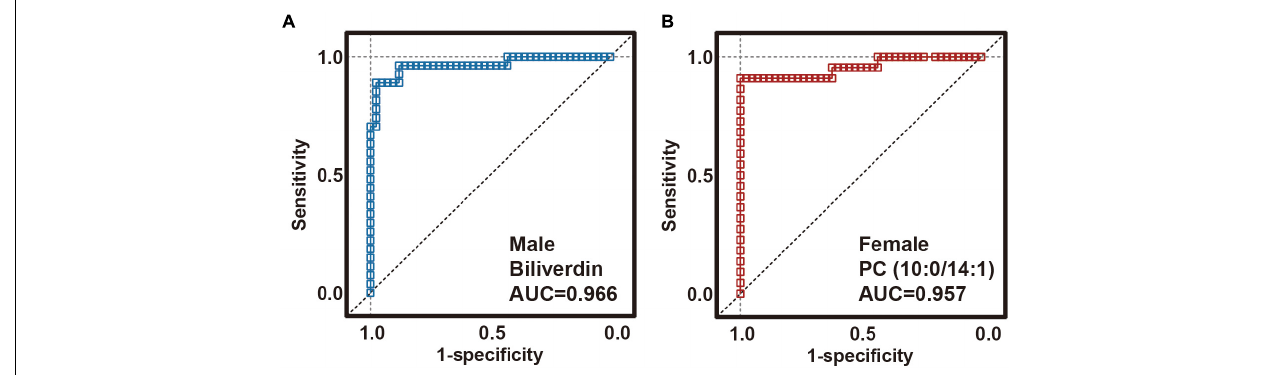
FIGURE 3 | Diagnostic performance of sex-specific plasma biomarkers. Receiver operating characteristic (ROC) analysis showing outstanding diagnostic performances of these sex-specific biomarkers. (A) The area under the curve (AUC) of the male-specific biomarker was 0.966. (B) AUC of the female-specific biomarker was